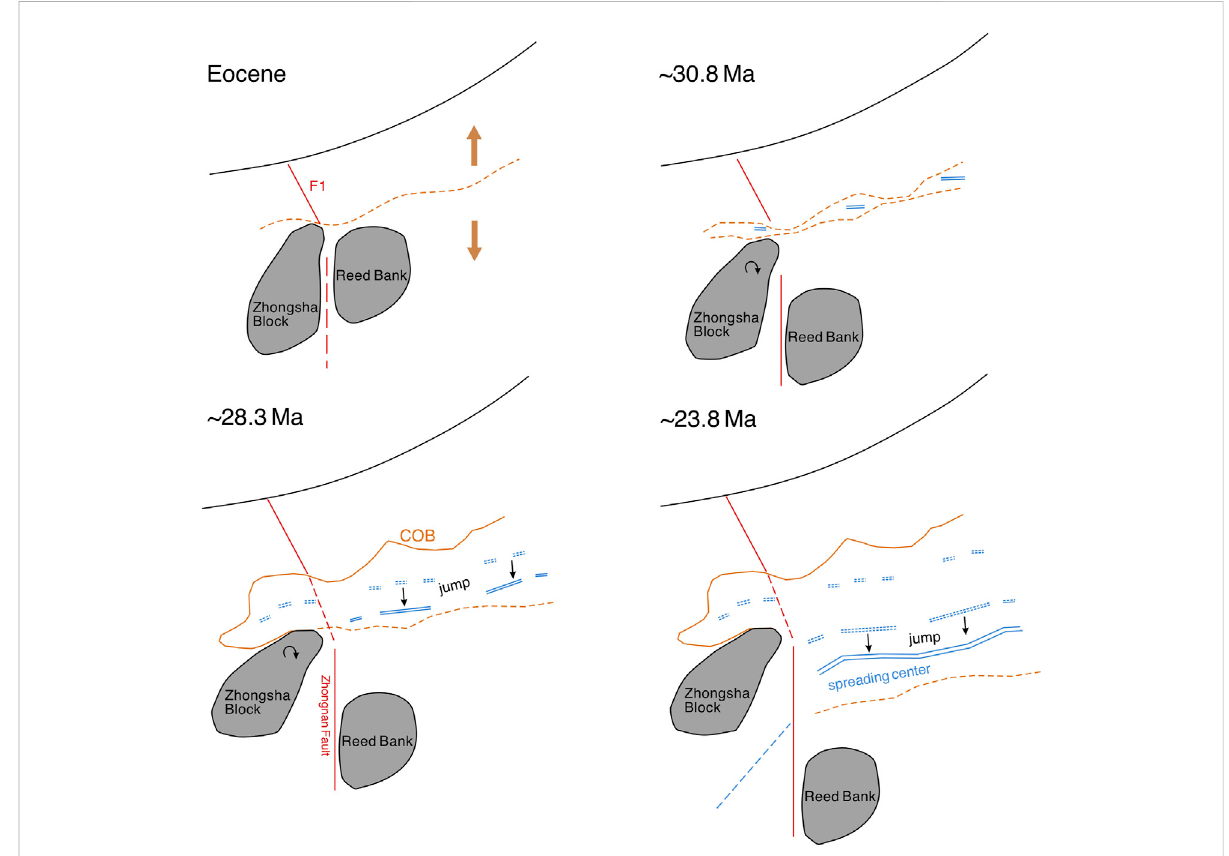
FIGURE 9 Schematic model of initial spreading and ridge jump in the northern